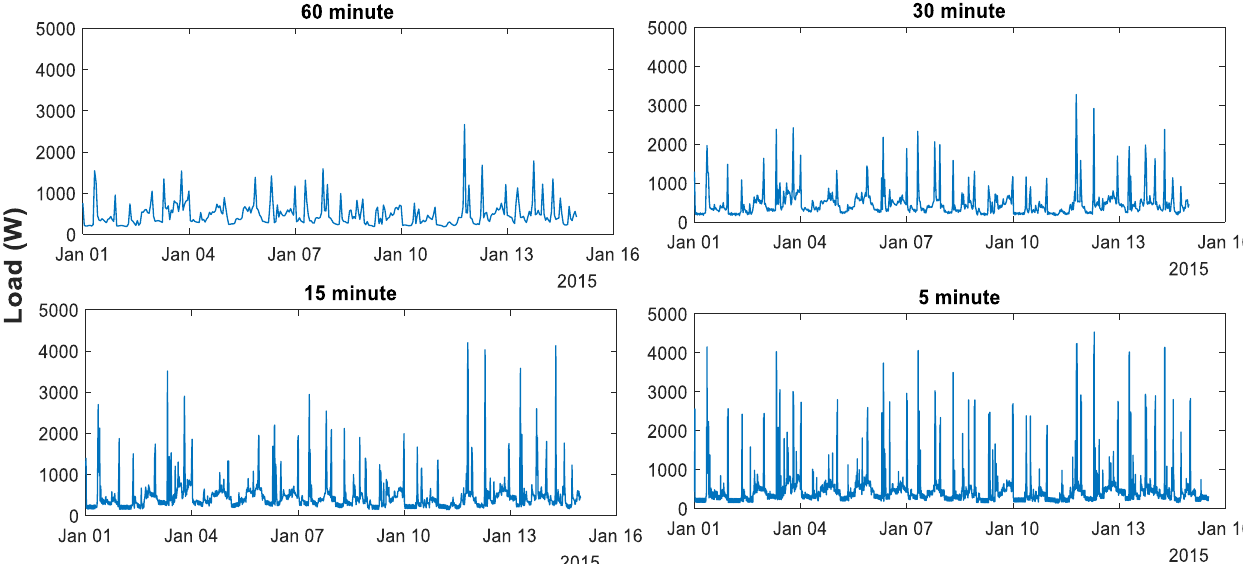
Fig. 5. Load pro fi le of the Household 11 at four different data resolutions between Jan 01 and Jan 15 2015.